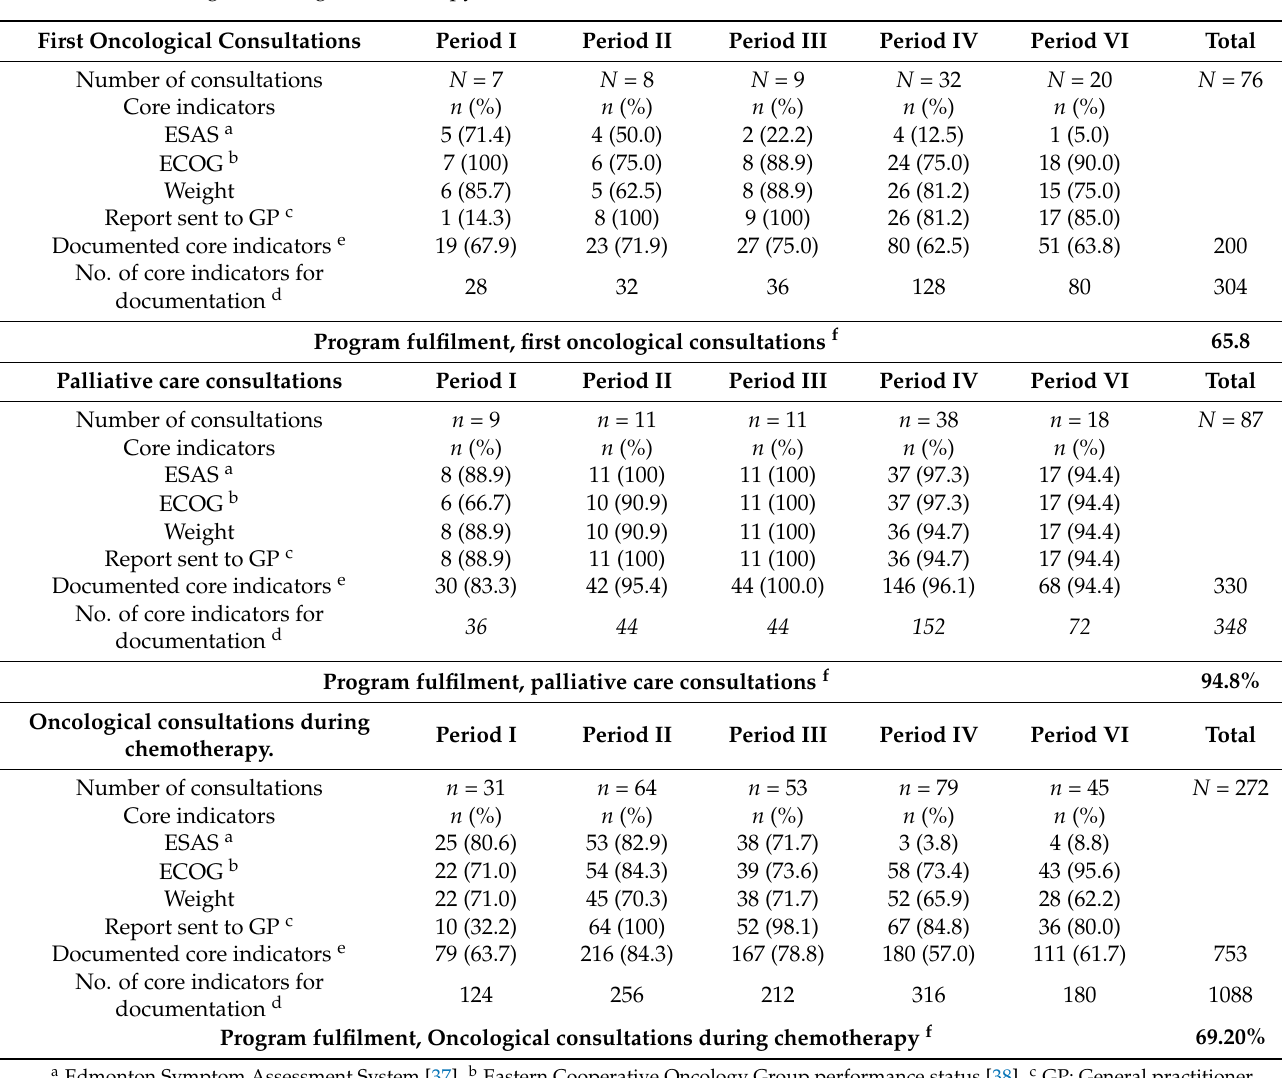
Figure 2. Program fulfilment, core indicators by period and consultation type. Table 2. Proportion of documented core indicators and program fulfilment, all consultation types; first oncological, palliative care and oncological during